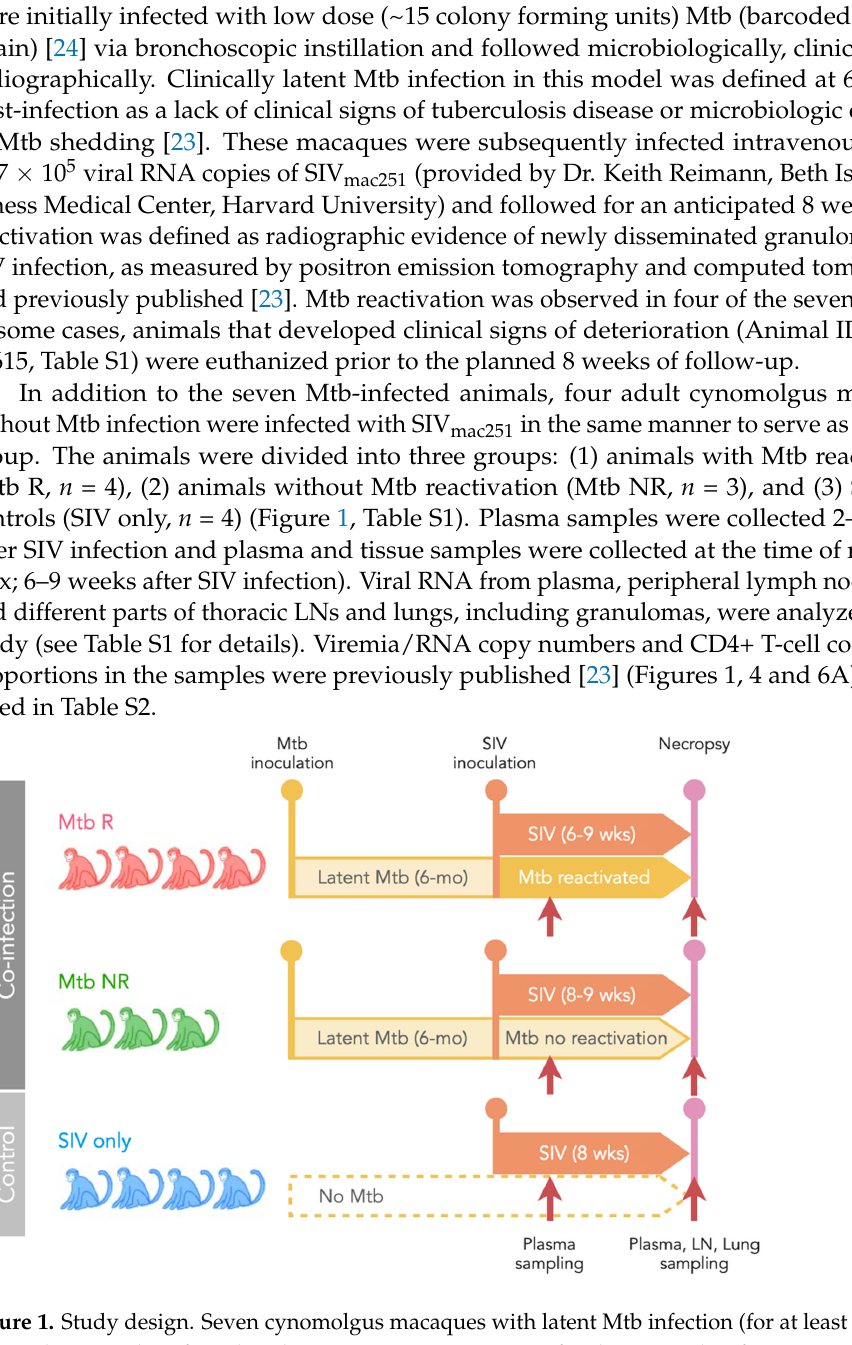
Figure 1. Study design. Seven cynomolgus macaques with latent Mtb infection (for at least 6 months) were subsequently infected with SIV mac251 . Reactivation of Mtb occurred in four animals (Mtb R) and Mtb did not reactivate in three animals (Mtb NR). A control group of four animals was infected only with SIV (SIV only). Plasma samples were collected at 2–3 weeks post-SIV infection and both plasma and tissues were collected at necropsy (6–9 weeks post-SIV